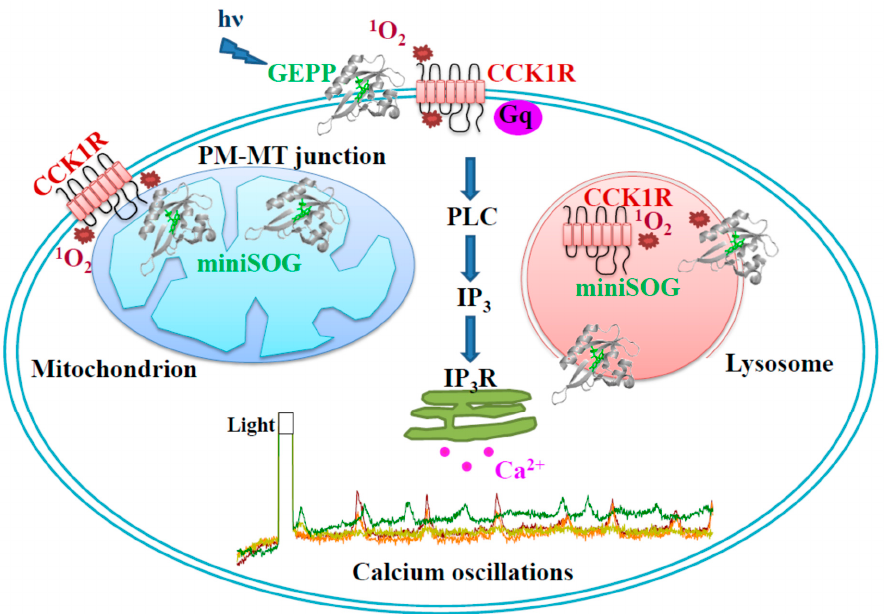
Figure 5. Plasma membrane (PM), mitochondrial (MT), and lysosomal (LS) miniSOG photodynamic actions induced calcium oscillations in AR4-2J cells. Plasma membrane (PM)-, mitochondria (MT)-, or lysosome (LS)-localized miniSOG upon blue LED light (h ν ) irradiation generates 1 O 2 , which